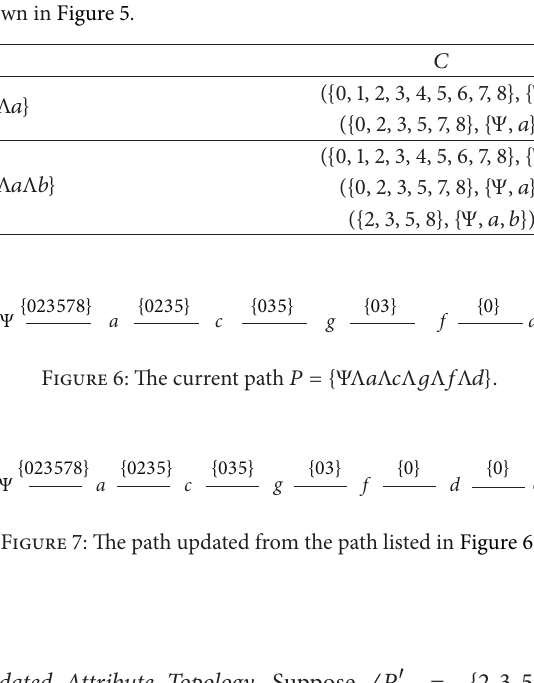
Table 2: The update on set 𝐶 , along with the update on the path shown in Figure 5.